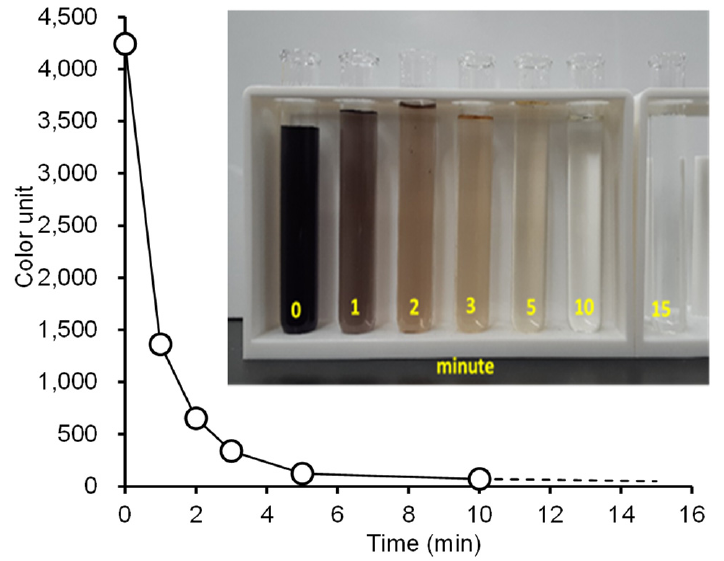
Figure 2. Decrease in the color unit (CU) of synthetic batik wastewater containing 48 mg/L RB5 and 48 mg/L RO16 after ozonation at 25 °C and pH 12. CU at 15 min was below the detection limit of 50.